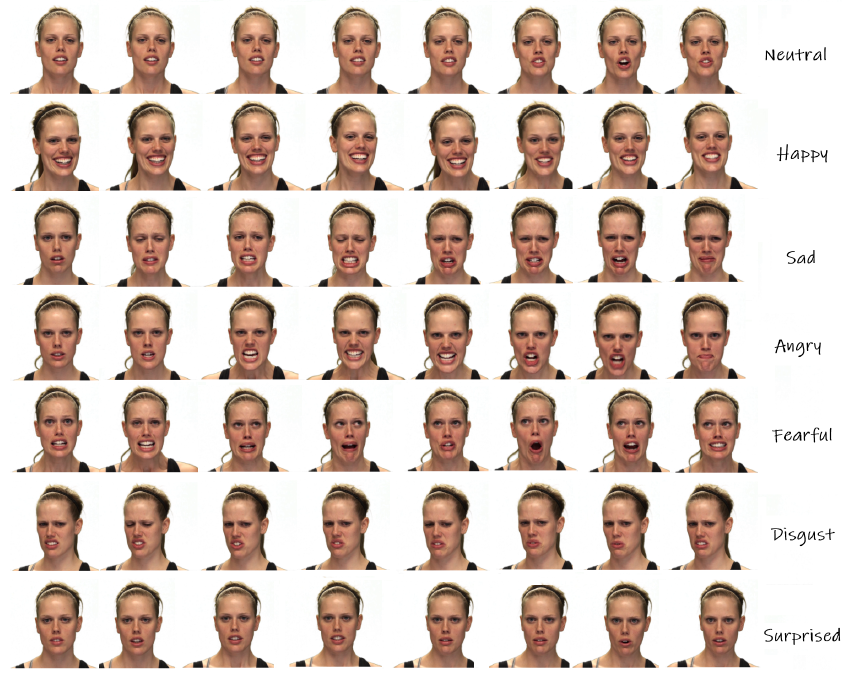
Figure 2. Video frames of visual facial expressions selected from RAVDESS (Ryerson Audio–Visual Database of Emotional Speech and Song)